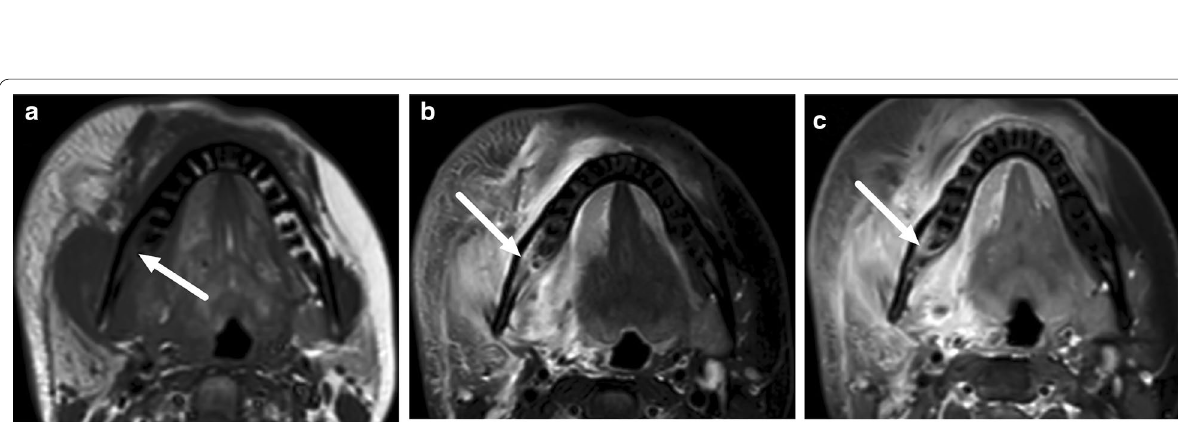
Fig. 19 Bone marrow edema as evidenced by low T1-signal ( a ) and high signal on fat-suppressed T2-weighted ( b ) and post-contrast T1-weighted ( c ) axial images (arrows) reliably suggest an odontogenic origin of infection. Image modified from ref.